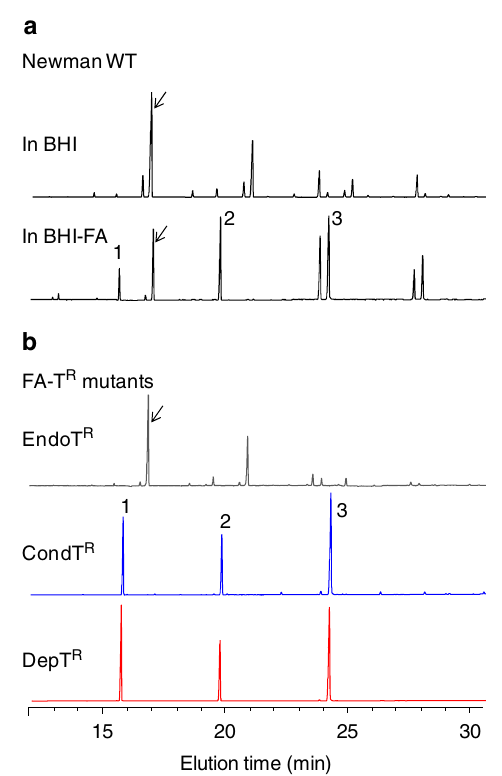
Figure 1 | S. aureus Newman WTand FA-T R mutants use exogenous fatty acids. Fatty acid profiles are shown for ( a ) Newman strain (WT) cultures grown in BHI and BHI-FA and ( b ) FA-T R clones grown in BHI-FA-T. S. aureus synthesizes branched chain fatty acids de novo , mainly C15:0 ( ai 15:0; indicated by arrow) and its elongation products, and saturated straight chain fatty acids. In BHI-FA, the WT strain uses exogenous fatty acids, but continues de novo synthesis. Peaks 1, 2, and 3 correspond to the exogenous fatty acids added during growth, respectively C14:0, C16:0, and C18:1 (collectively referred to as ‘FA’, see Methods). EndoT R , FA-T R with endogenous fatty acids (grey); CondT R , FA-T R with conditional FASII activity (blue), that is, active in BHI but bypassed in fatty acids plus triclosan; DepT R , FA-T R requiring exogenous fatty acids for growth (red). The fatty acid profile of the EndoT R mutant was similar to that of the WT in BHI, while CondT R and DepT R profiles are